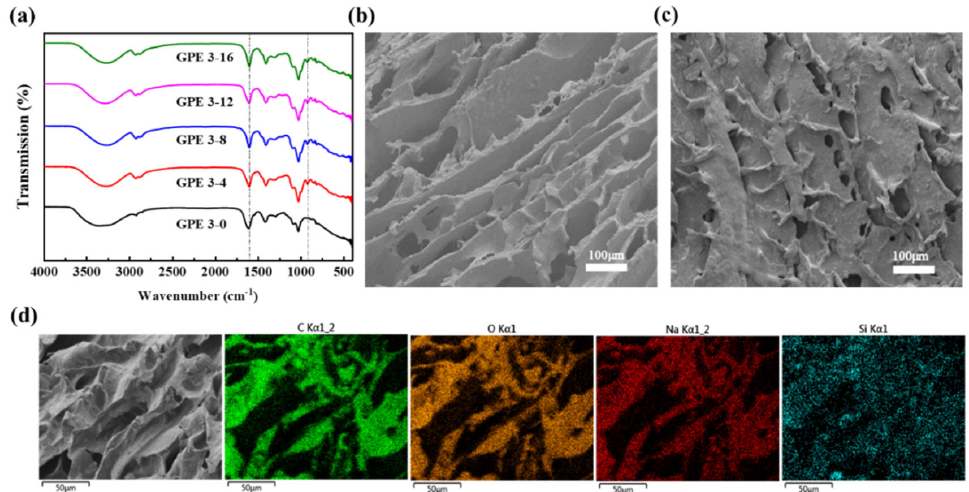
Figure 2. ( a ) FT ‐ IR spectra of SiO 2 ‐ SA GPE; SEM images of GPE ( b ) cross ‐ section and ( c ) surface; Figure 2. ( a ) FT-IR spectra of SiO 2 -SA GPE; SEM images of GPE ( b ) cross-section and ( c ) surface; ( d ) EDS element maps of GPE. ( d ) EDS element maps of GPE.